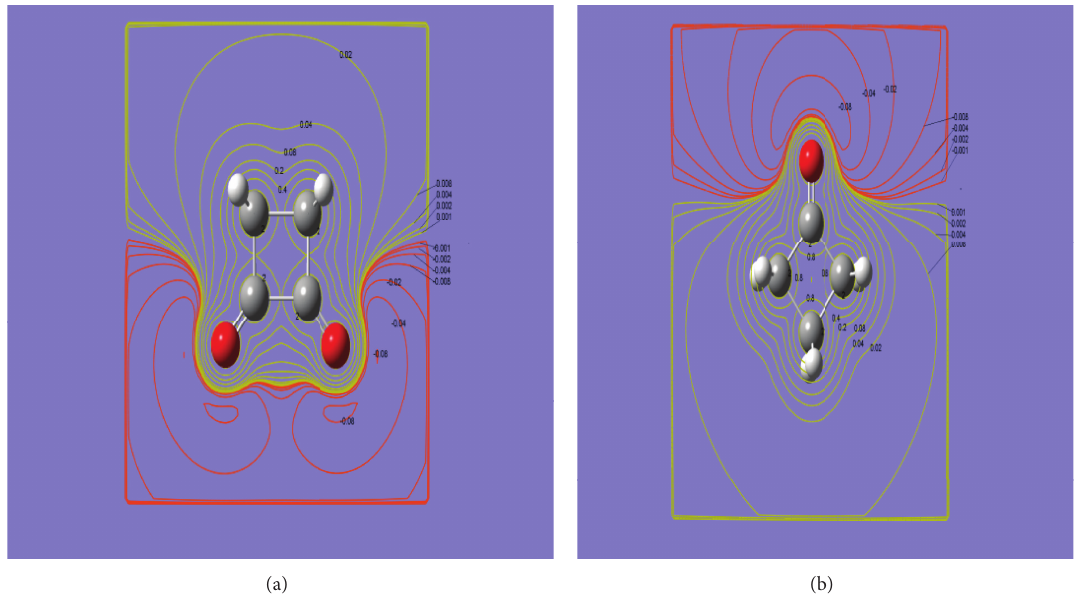
F 7: Contour plots of 1,2-cyclobutanedione and